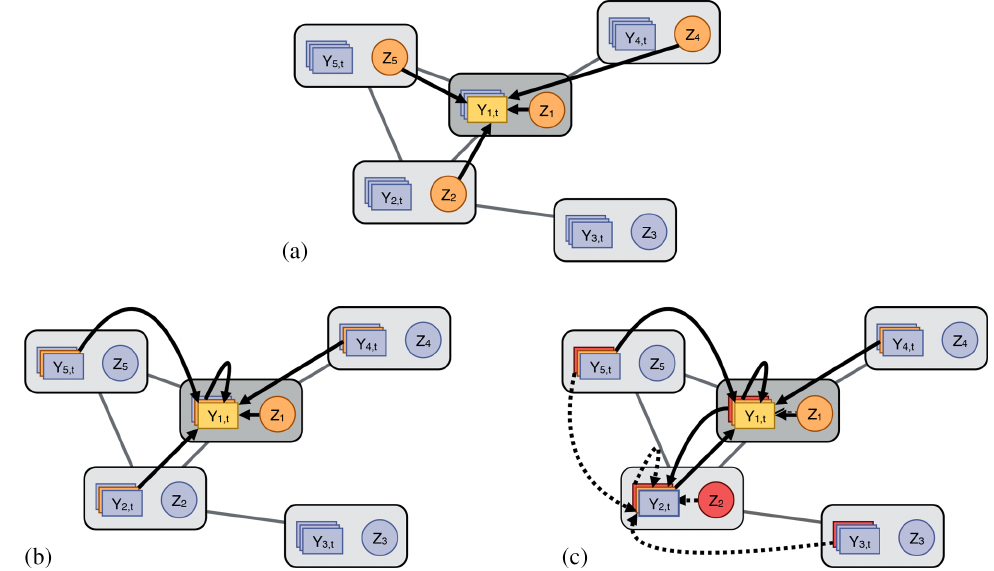
Figure 2 Varieties of interference illustrated in a small social network. (a) Interference under the neighborhood treat- ment response (NTR) assumption, where the response of vertex 1 at time t (light orange) depends on the treatments of its neighbors and itself (dark orange). (b) Interference due to social interactions (i.e., peer effects, social contagion), where the response of vertex 1 at time t depends on its own treatment u and the responses of its neighbors at time t − 1. (c) In- 1 terference caused by social interactions induces long range dependence; for example, the response of vertex 3 at time t − 1 in turn depends on vertex 3 ’ s treatment and the responses of their neighbors at time t − 2 (dashed lines and red objects). Interference under the NTR assumption has no long range dependence, but is much less